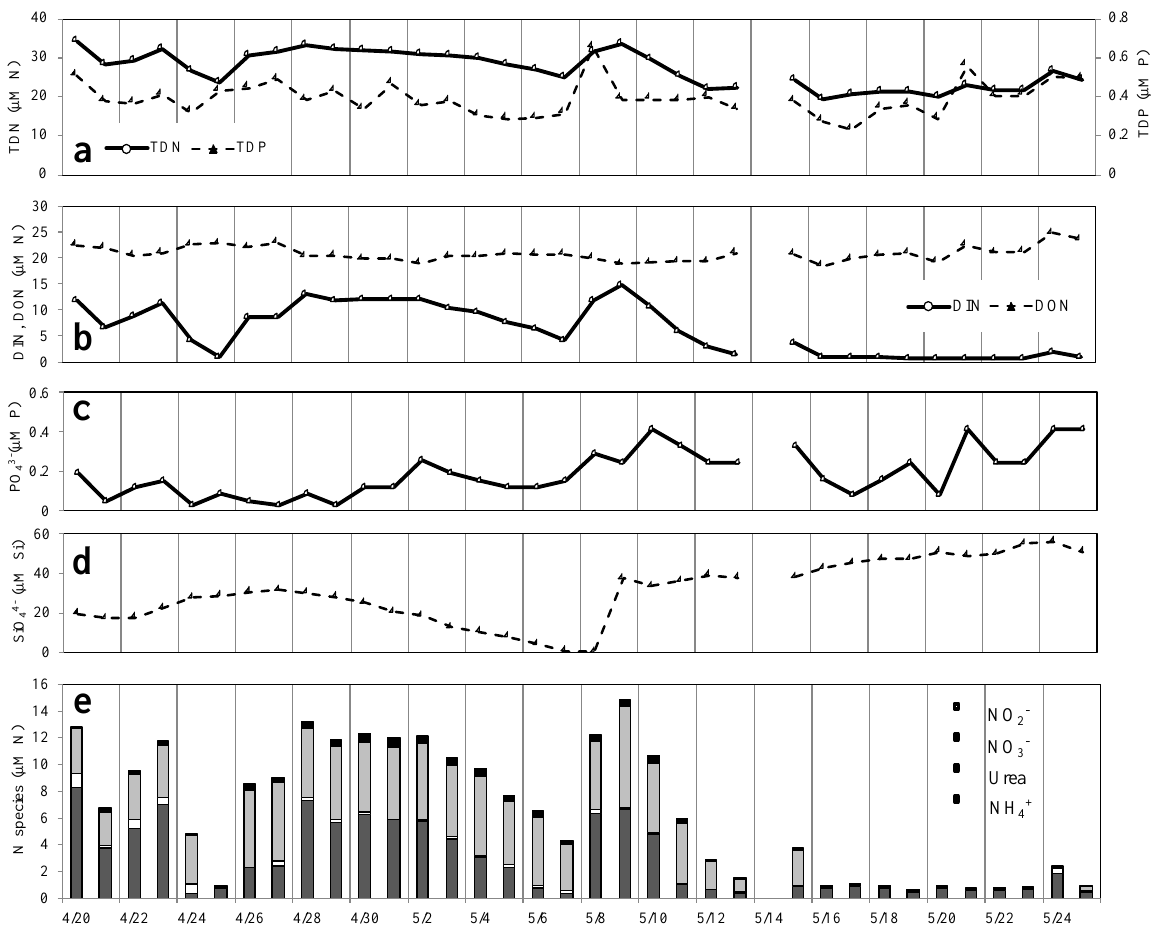
Figure 6. Nutrient concentrations measured in the Lafayette River from 20 April to 25 May 2006. Daily measurements of total dissolved nitrogen (TDN, µM N) and total dissolved phosphorus (TDP, µM P) ( a ), dissolved inorganic nitrogen (DIN, µM N) and dissolved organic nitrogen (DON, µM N) ( b ), orthophosphate (µM P) ( c ), dissolved silicate (µM Si) ( d ), and dissolved nitrogen concentrations by species ( e